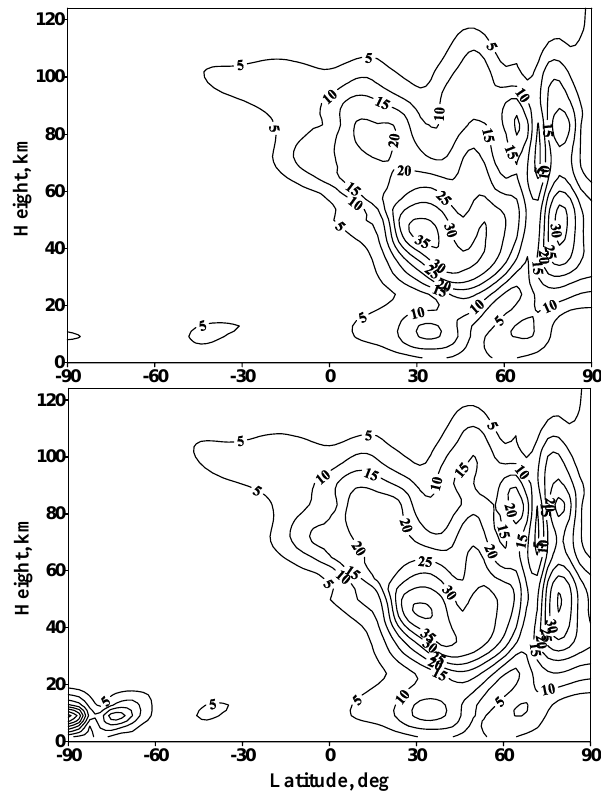
Fig. 8. SPW1 amplitude in zonal wind (m/s) calculated using zonal mean flow for January 1960 (upper panel) and January 2000 (lower